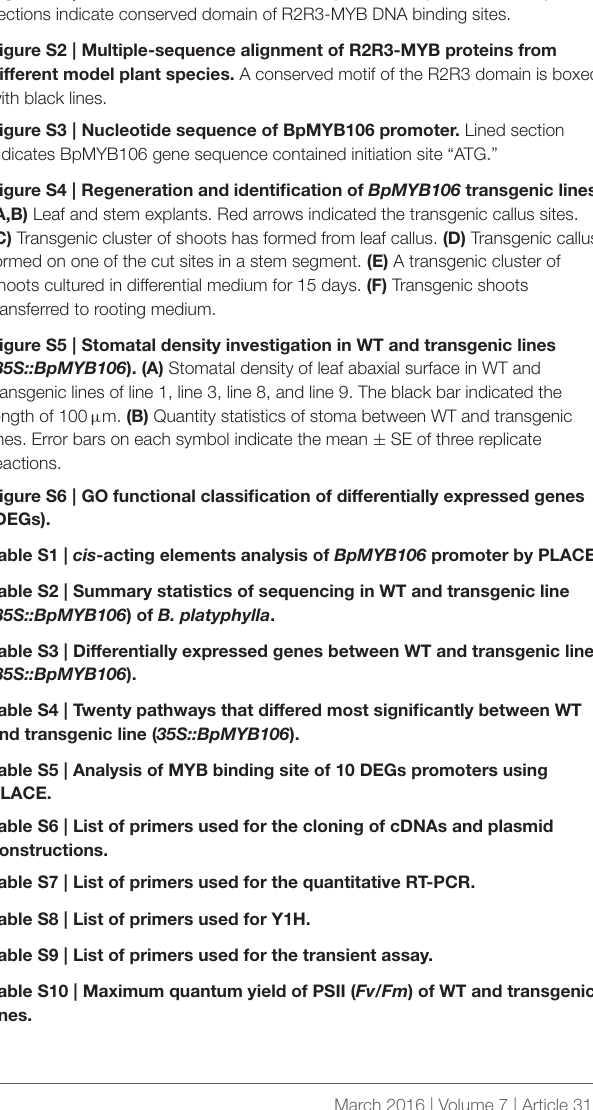
Table S7 | List of primers used for the quantitative RT-PCR. Table S8 | List of primers used for Y1H. Table S9 | List of primers used for the transient